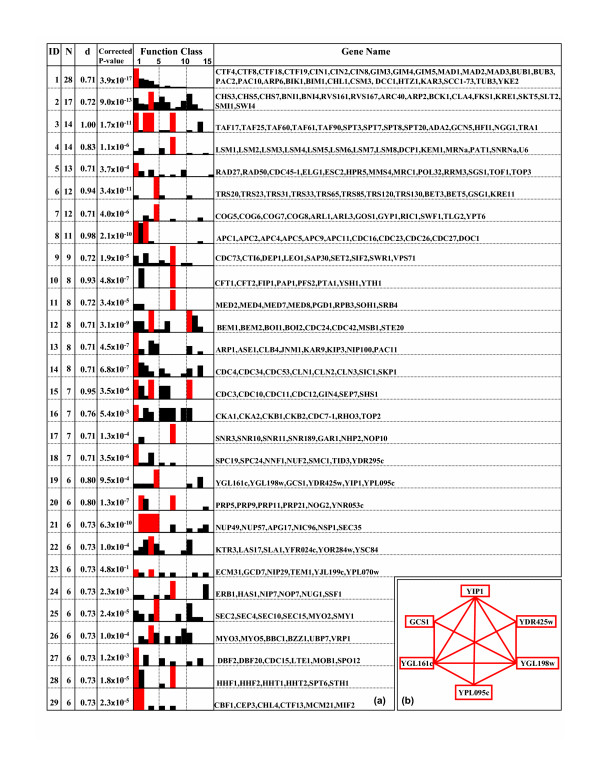
Complexes that are of size ≥ 6 of the set generated using din = 0.7, cpin = 0.50 and non-overlapping mode. (a) ID, size N, density d, p-value (with Bonferroni correction), a corresponding histogram and the names of the constituent proteins of each complex. The histogram of a complex shows the distribution of its member proteins with respect to 15 functional classes: (1) Cell cycle and DNA processing, (2) Protein with binding function or cofactor requirement (structural or catalytic), (3) Protein fate (folding, modification, destination), (4) Biogenesis of cellular components, (5) Cellular transport, transport facilitation and transport routes, (6) Metabolism, (7) Interaction with the cellular environment, (8) Transcription, (9) Energy, (10) Cell rescue, defense and virulence, (11) Cell type differentiation, (12) Cellular communication/signal transduction mechanism, (13) Protein activity regulation, (14) Protein synthesis, and (15) Transposable elements, viral and plasmid proteins. A protein may belong to more than one functional class. The scaling of a histogram is according to the size of the corresponding complex. The highest column/columns of a histogram are colored as red. (b) The network of the complex 19 of Fig 7(a).